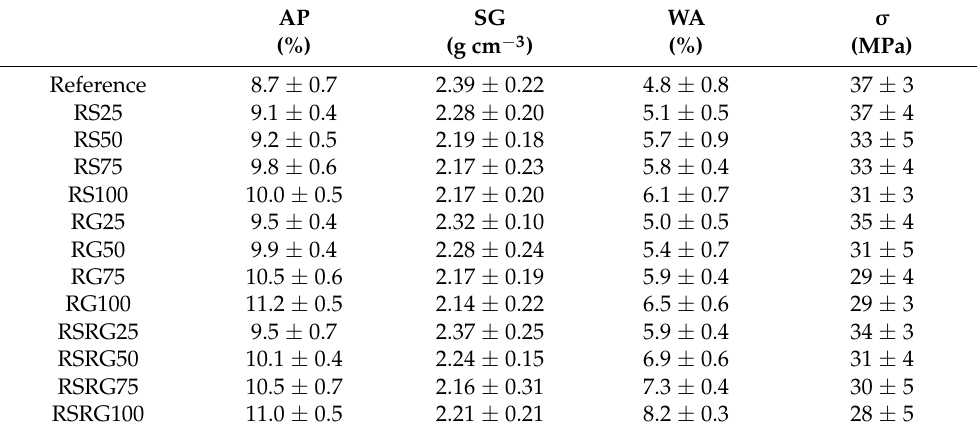
Table 3. Technological properties (n = 10) of the different compositions of concrete test specimens prepared with RAs (after 28 days of curing). Uncertainties given as standard deviation of the mean: u = (S x /n 1/2 ), S x being the standard deviation of the samples.